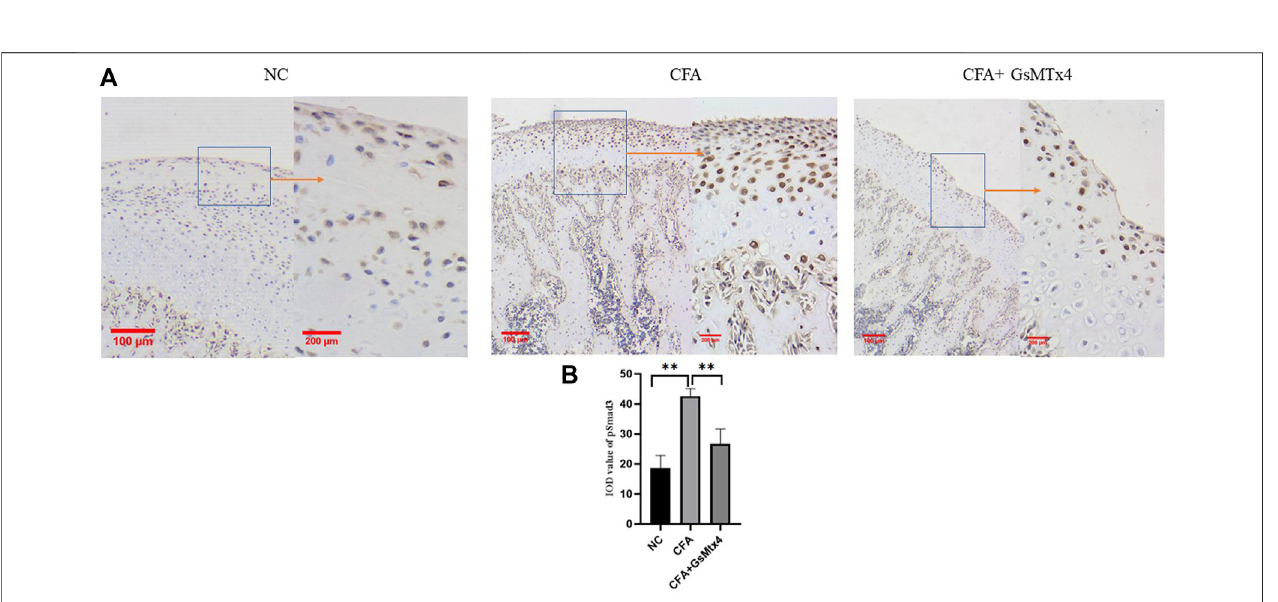
FIGURE 5 | (A) Expression of Piezo1 in each group. (B) Statistical analysis of the Piezo1 expression in each group. * p < 0.05.